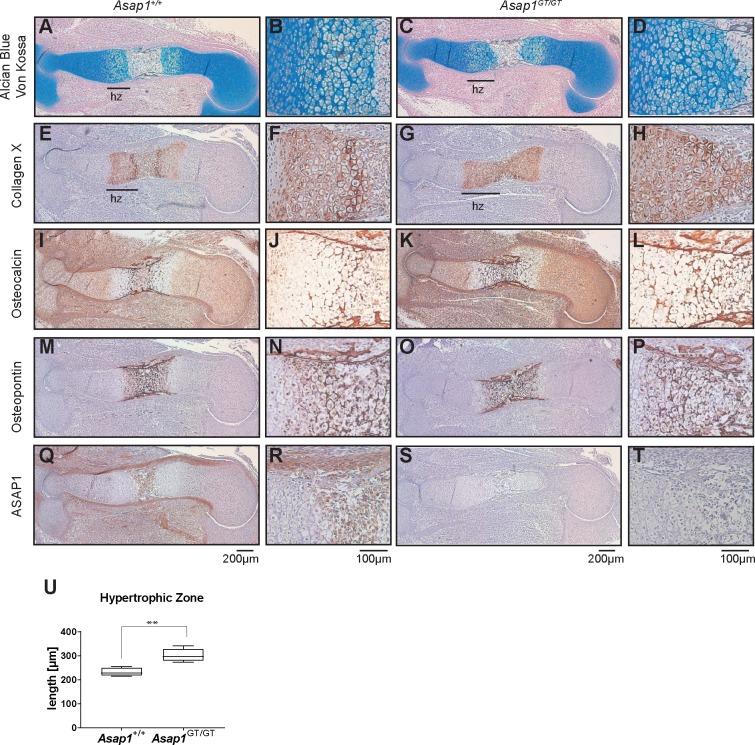
Loss of ASAP1 results in expansion of the hypertrophic zone.(A-D) E15.5 Asap1+/+ and Asap1GT/GT growth plates of the humerus stained for Alcian Blue / von Kossa in blue and black, respectively. The length of the hypertrophic zone (hz) is demarcated by a black bar. (E-T) Immunostaining of E15.5 Asap1+/+ and Asap1GT/GT humeral growth plates. Staining of the hypertrophic marker collagen X (E-H) and the osteogenic markers osteocalcin (I-L) and osteopontin (M-P) was detected by Nova Red and counterstained with hematoxilin. ASAP1 immunostaining indicates specific expression of ASAP1 in the perichondrium, in late hypertrophic chondrocytes and in the primary ossification center (Q-T). The scale bars shown at the bottom of the panels apply to all pictures above the given scale bar. (U) Quantification of the distal hypertrophic zones of the humerus of Asap1+/+ and Asap1GT/GT animals (Asap1+/+ n = 5, Asap1GT/GT n = 5). Graphs show the mean ± SD. Significance was calculated using the Student’s t-test. **, p <0.005.